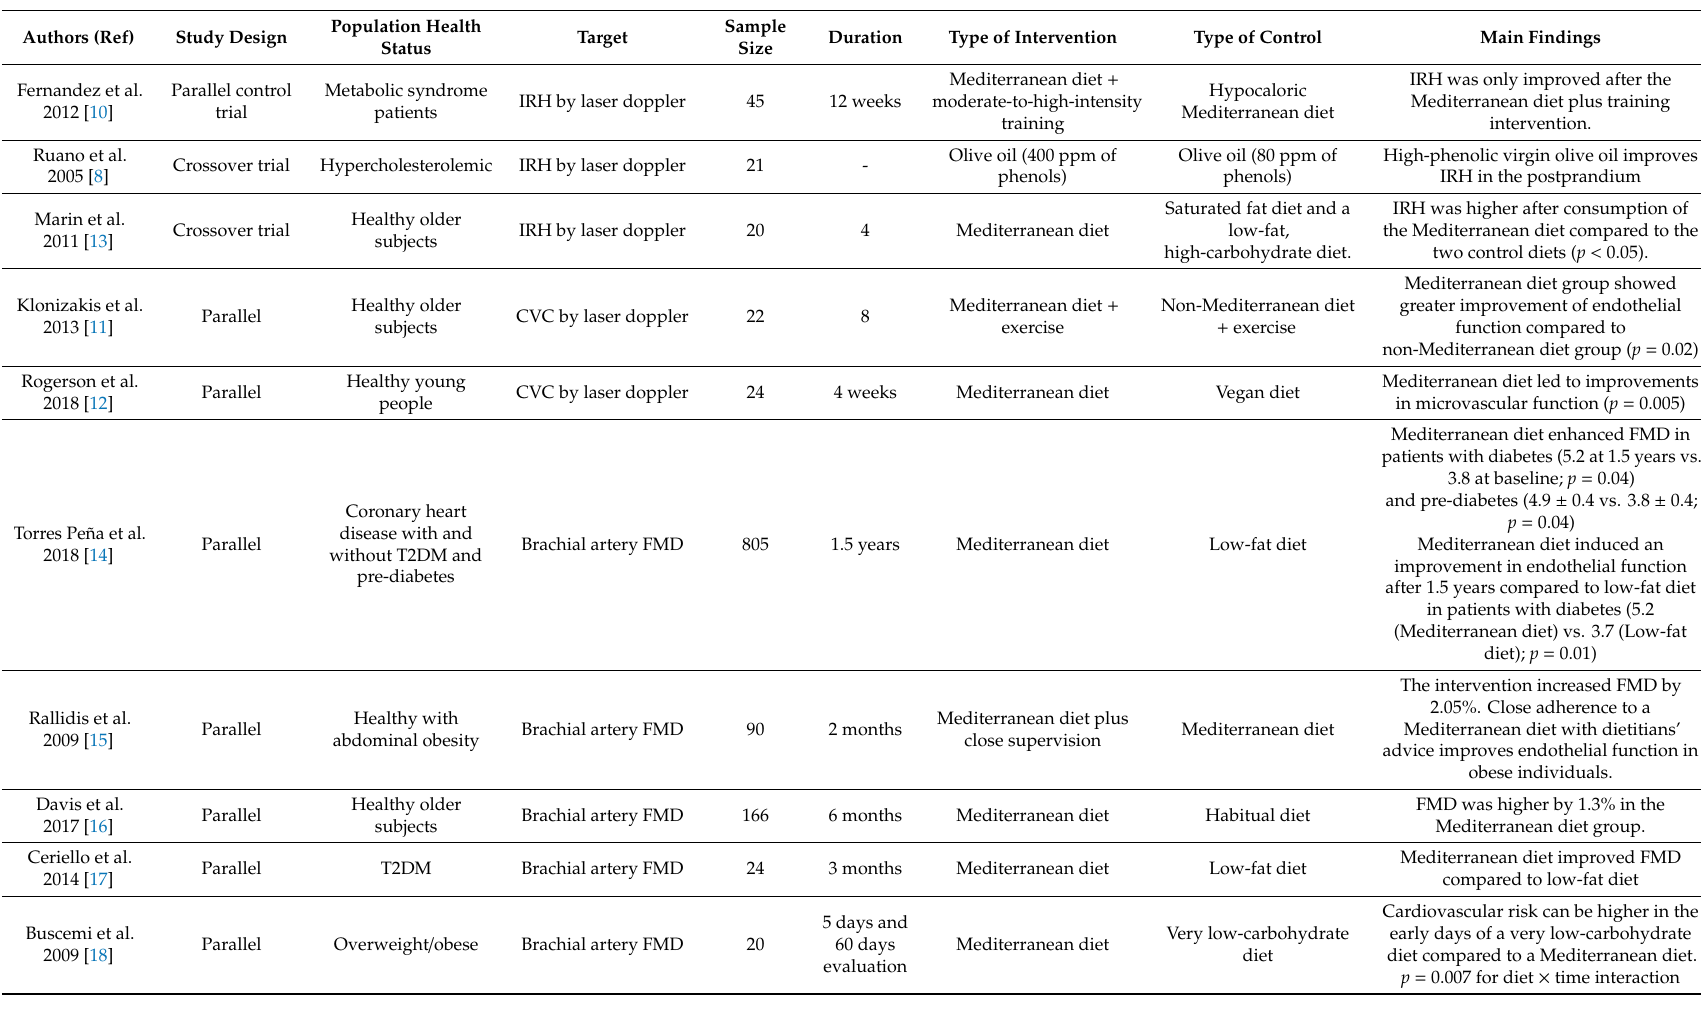
Table 1. Summary of the main characteristics of the trials investigating the e ff ects of Mediterranean diet on endothelial